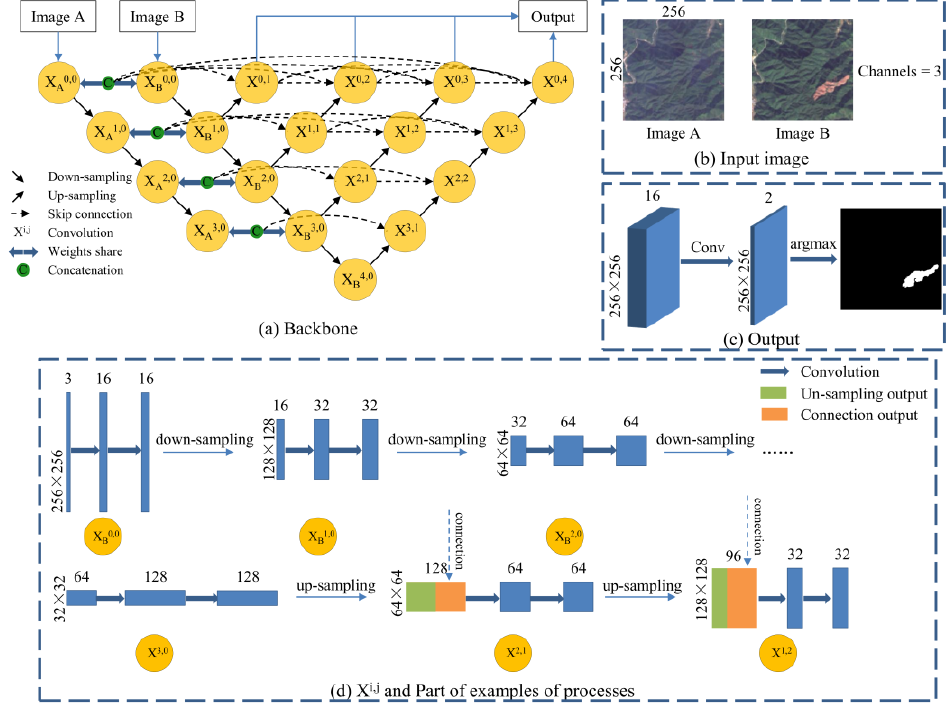
Figure 6. Change detection model (U-Net++).